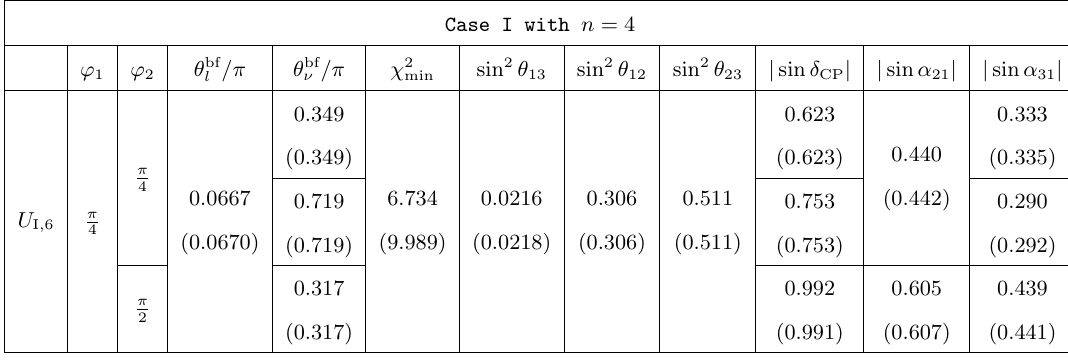
Table 4 . Results of the (cid:31) 2 analysis for n = 4 in case I. The (cid:31) 2 function obtains a global minimum (cid:31) 2 at the best (cid:12)t values ( (cid:18) l ; (cid:18) (cid:23) ) = ( (cid:18) bf ; (cid:18) bf ). We display the values of the mixing angles and CP (cid:23) min l violation phases at the best (cid:12)tting point. The same values of mixing parameters as well as (cid:31) 2 are achieved at ( (cid:18) l ; (cid:18) (cid:23) ) = ( (cid:25) (cid:0) (cid:18) bf ; (cid:25) (cid:0) (cid:18) bf ), because the formulae of the mixing angles and CP (cid:23) l invariants in table 3 are not changed, if (cid:18) l and (cid:18) (cid:23) are replaced by (cid:25) (cid:0) (cid:18) l and (cid:25) (cid:0) (cid:18) (cid:23)